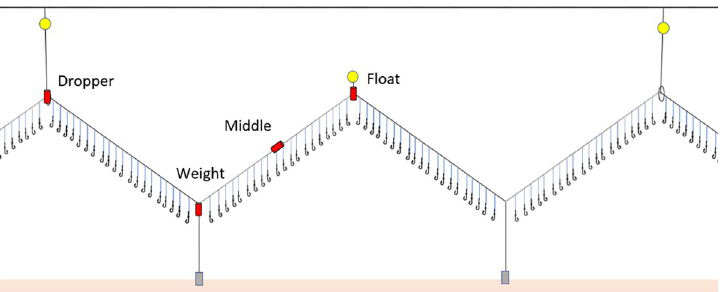
Fig 3. Time Depth Recorders’ deployment on the fishing gear. The red cylinders indicate where the Time Depth Recorders were deployed on the floated demersal